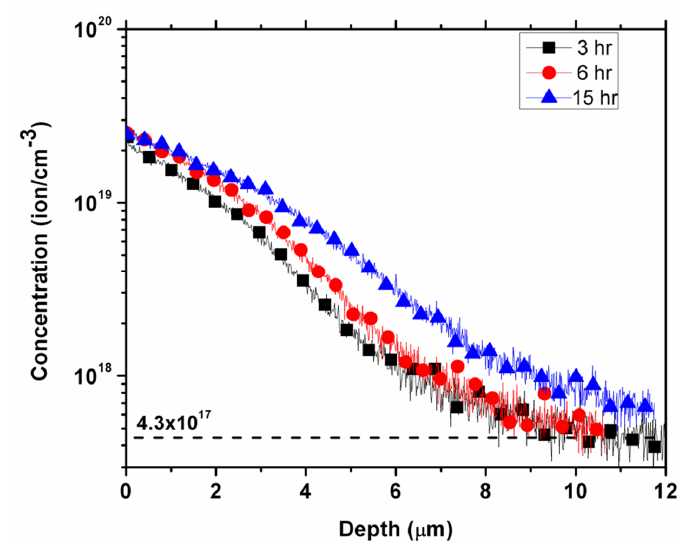
Figure 1. Concentration depth profiles of ZnO single crystals after in-diffusion of Cu performed at 1000 °C for 3h, 6h and 15h.